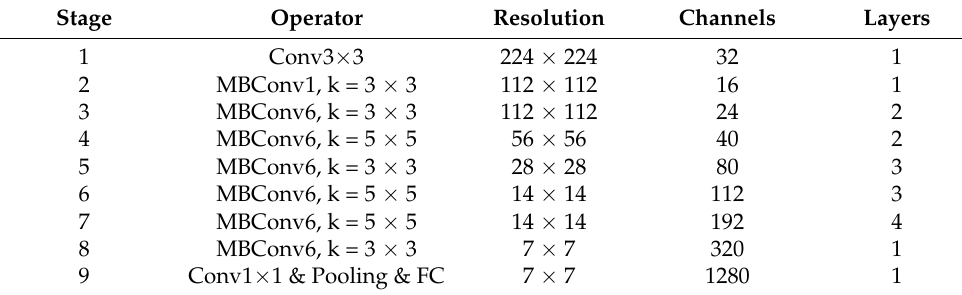
Table 3. EfficientNet-B0 network structure of the baseline network.